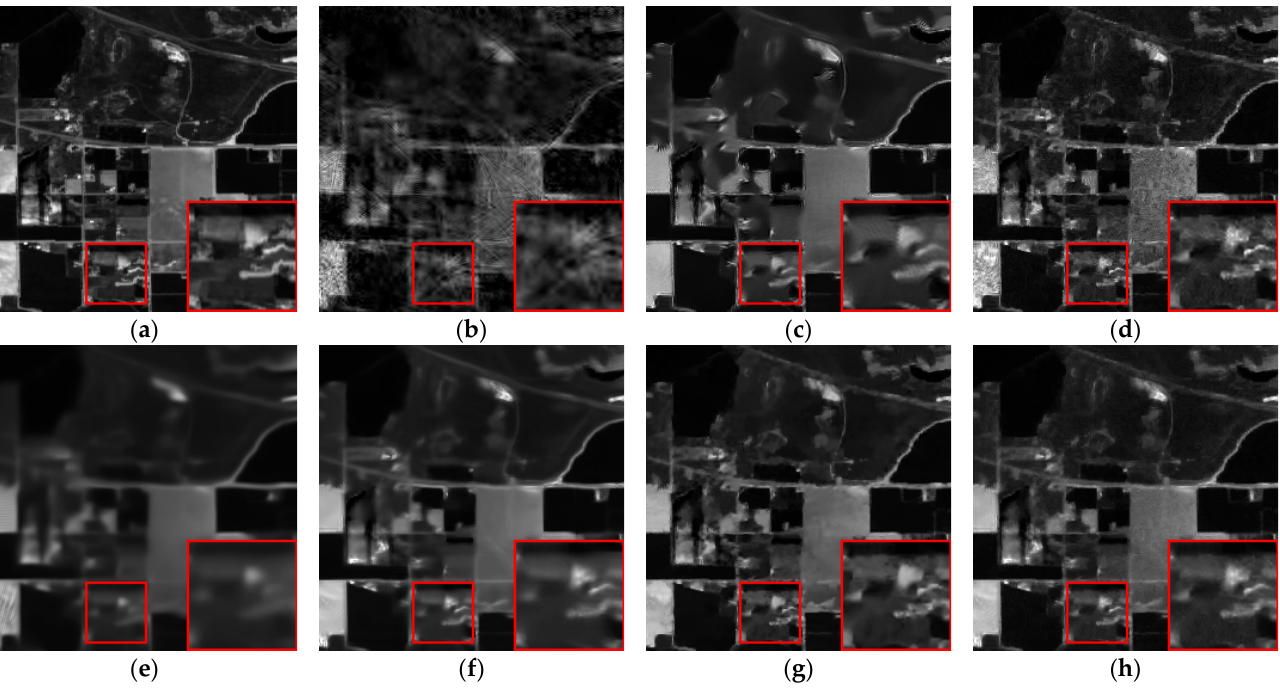
Figure 9. The results of all filters on S1 ( L = 1). The red box highlights the zoomed region of interest. ( a ) Clean image; ( b ) Wavelet-Contourlet filter (W-C); ( c ) PPB; ( d ) SAR-BM3D; ( e ) H-WNNM; ( f ) GNLM; ( g ) Fast Adaptive Non-Local SAR (FANS); ( h ) Proposed method.